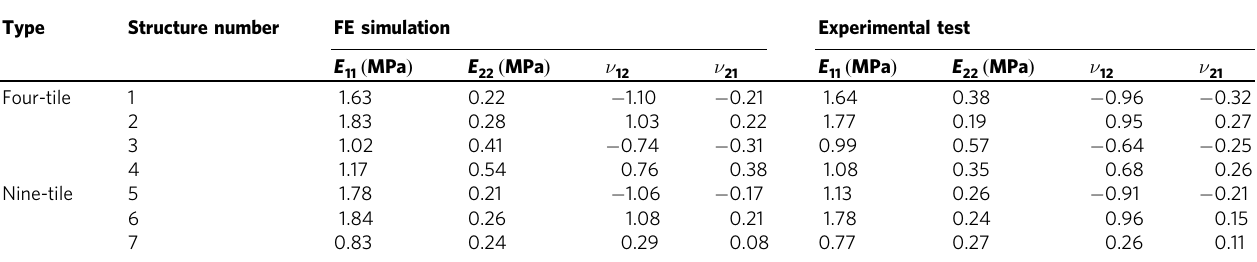
Table 1 Comparisons between the computationally determined and experimentally measured elastic properties of the multi-tile